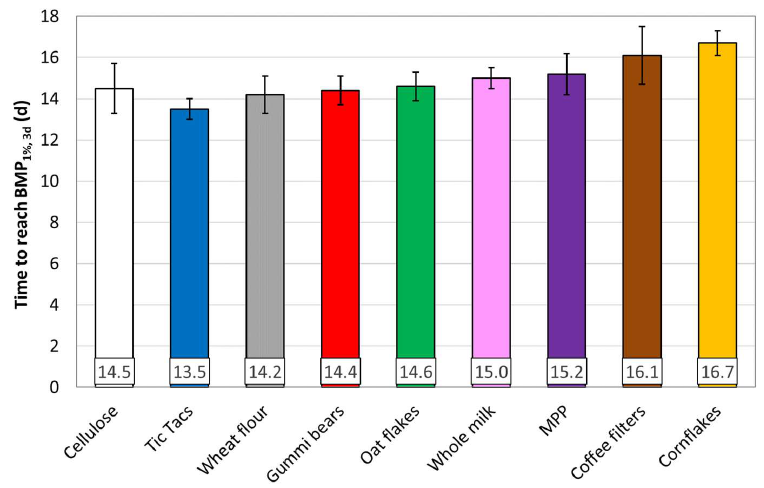
Figure 4. Time to reach the termination criterion BMP 1% net, 3d for microcrystalline cellulose and alternative positive control substrates. Error bars indicate standard deviation ( n = 9 for microcrystalline cellulose and n = 3 for all other substrates). Values have been sorted in ascending order.